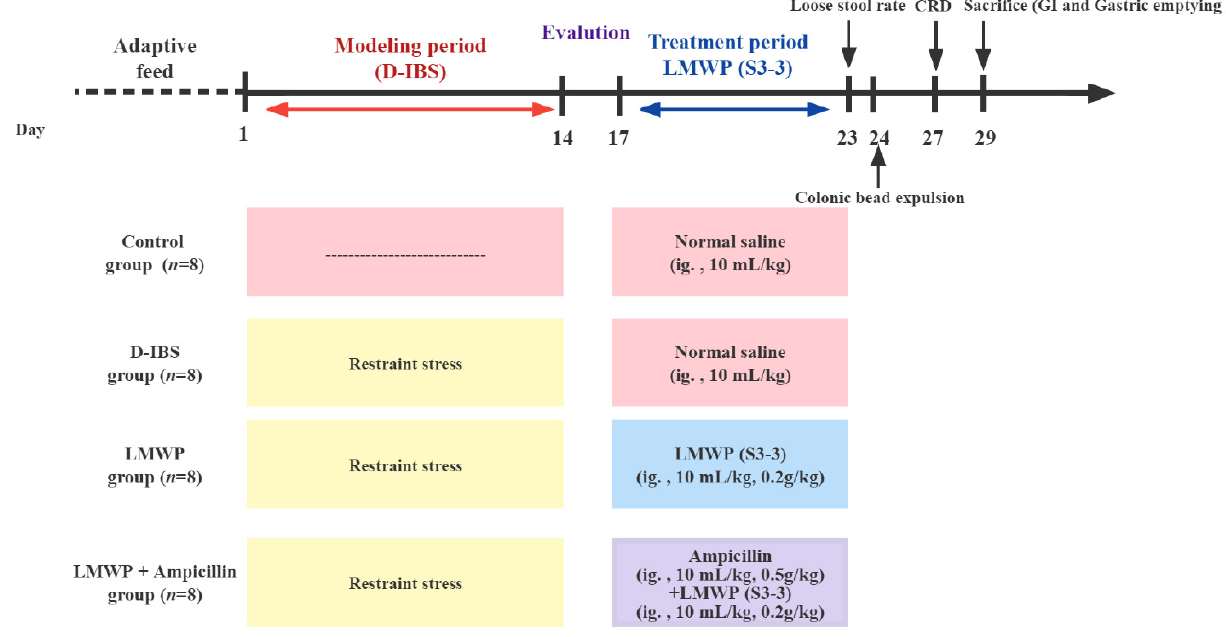
Figure 1. Timeline of experimental procedures.